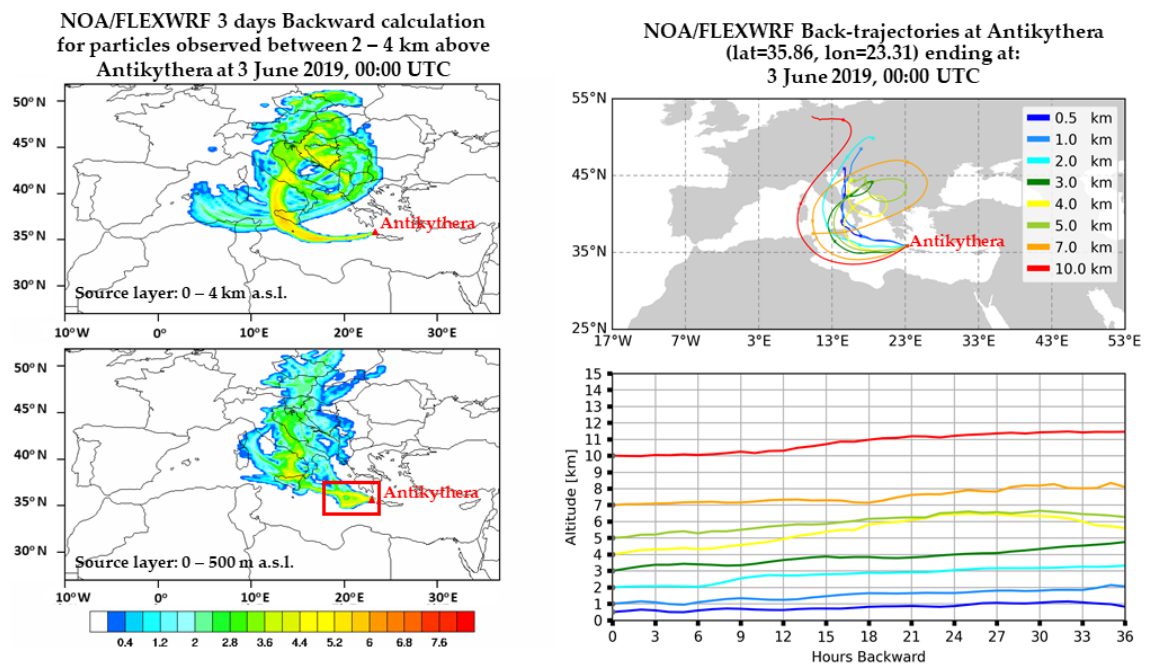
Figure 12. FLEXPART Source–Receptor Relationships ((log)(sm 3 kg − 1 )) for air masses originating from ( a ) 0–4 km a.s.l. and ( b ) 0–500 m a.s.l. arriving at Antikythera between 2 and 4 km and ( c ) FLEXPART back-trajectories at Antikythera on 3 June 2019, 00:00 UTC. The location of the possible dust-prone areas above Mediterranean Sea is marked with a red square in Figure 12b.